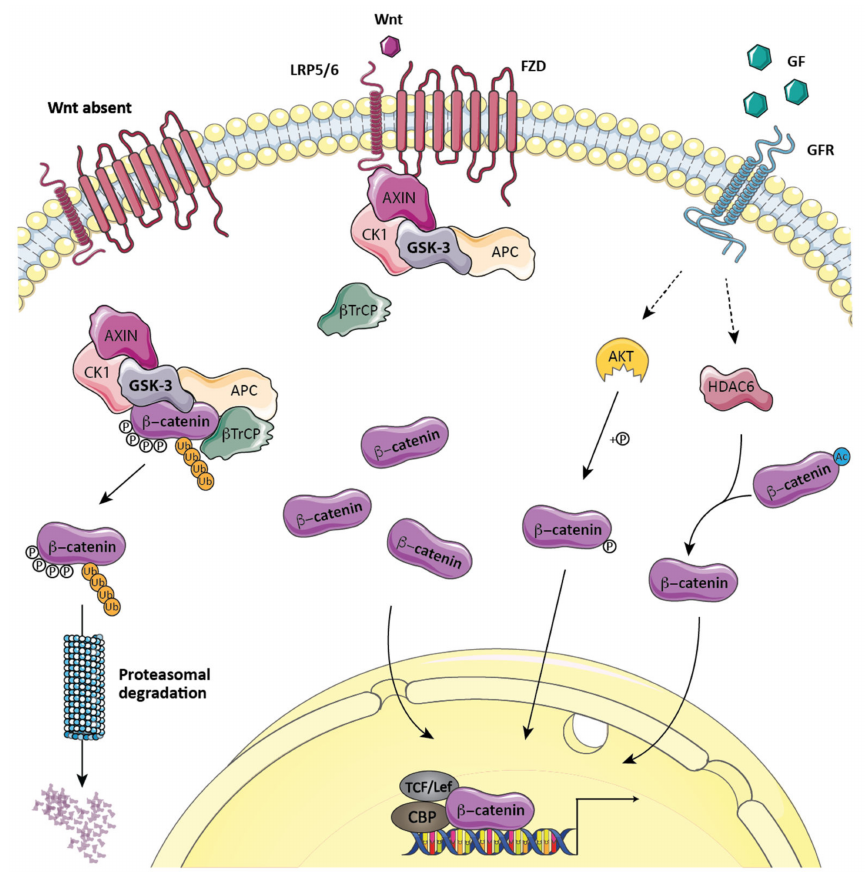
Figure 1. Wnt / β -catenin signaling. Whereas the vast majority of β -catenins function as adapter molecules at the cell membrane, linking cadherin receptors to the actin cytoskeleton (not shown), a small cytoplasmic pool of β -catenins plays key roles in transcriptional events. In the absence of Wnt ligands, the level of β -catenin in cytoplasm is kept low by a process involving the ubiquitin-proteasome system that employs a multiprotein destruction complex containing glycogen synthase kinase (GSK)-3 α / β , casein kinase 1 (CK1), axin, adenomatous polyposis coli (APC), protein phosphatase 2A (PP2A) (not shown), and the E3-ubiquitin ligase beta-transducin repeats-containing proteins ( β -TrCP). The engagement of Wnt ligands to frizzled / LRP receptors results in the destabilization of the destruction complex (the release of β -TrCP), thus allowing for the cytoplasmic accumulation of neo-synthetized β -catenin, followed by its nuclear translocation and binding to lymphoid enhancer factor / T-cell factor (LEF / TCF). Along with CBP / p300, they induce a gene network involved in cell proliferation, di ff erentiation, and lineage commitment. Another mechanism of β -catenin nuclear translocation is the growth factor (GF) receptor (GFR)-mediated, AKT-dependent phosphorylation of β -catenin at Ser552 or its deacetylation by HDAC6 at Lys49. The model was created using Servier Medical Art